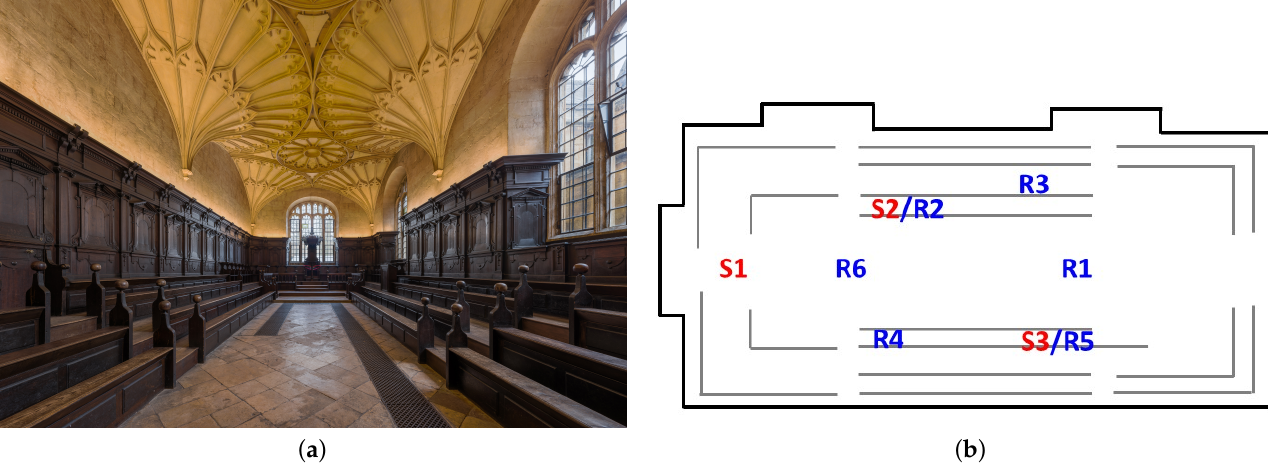
Figure 11. ( a ) Convocation House, University of Oxford, photo by DAVID ILIFF. Licence: CC BY-SA 3.0 via Wikimedia Commons [46] and ( b ) floor plan of the measured